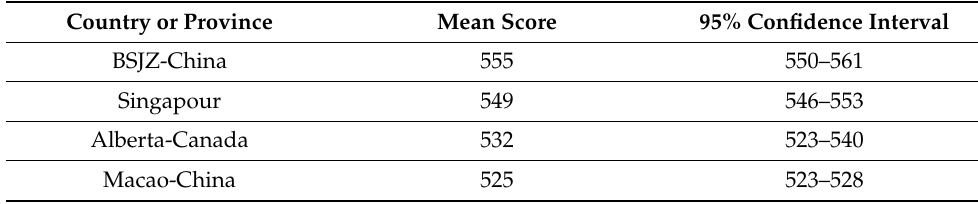
Table A1. Top ten mean country scores—PISA